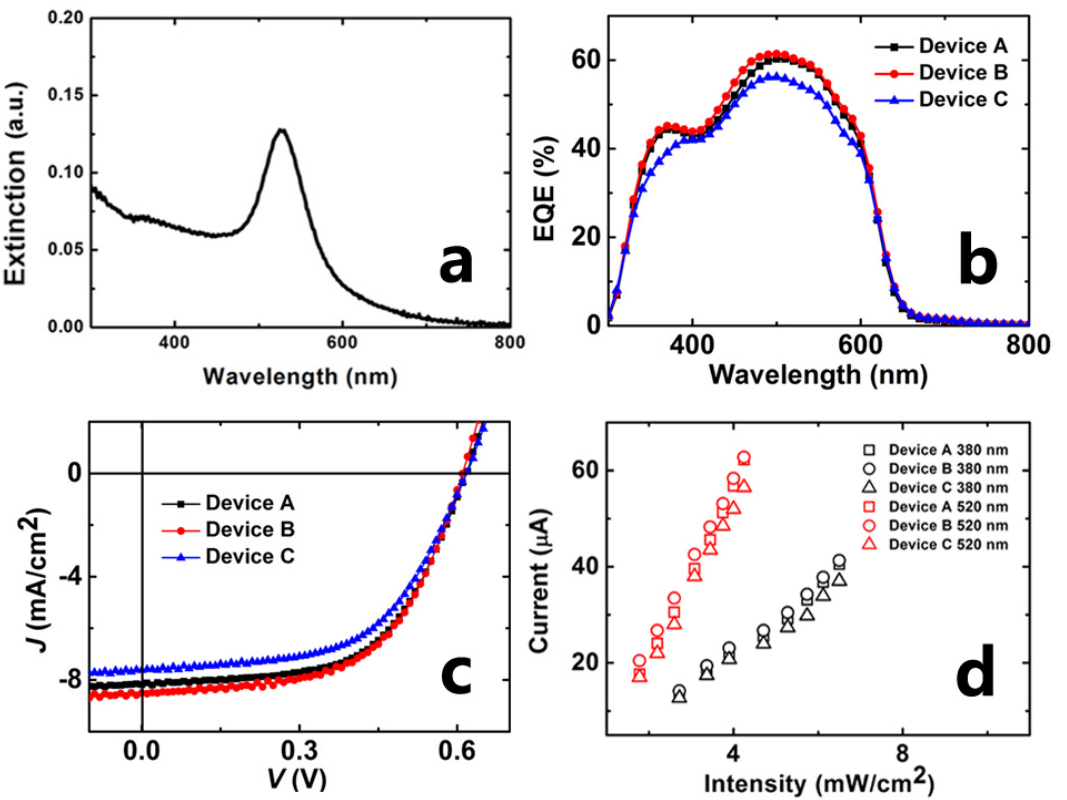
Figure 2. The extinction spectrum of the colloidal solution of Au NPs ( a ); the external quantum efficiency (EQE) curves ( b ); J - V characteristics of devices under AM1.5G 100 mW/cm 2